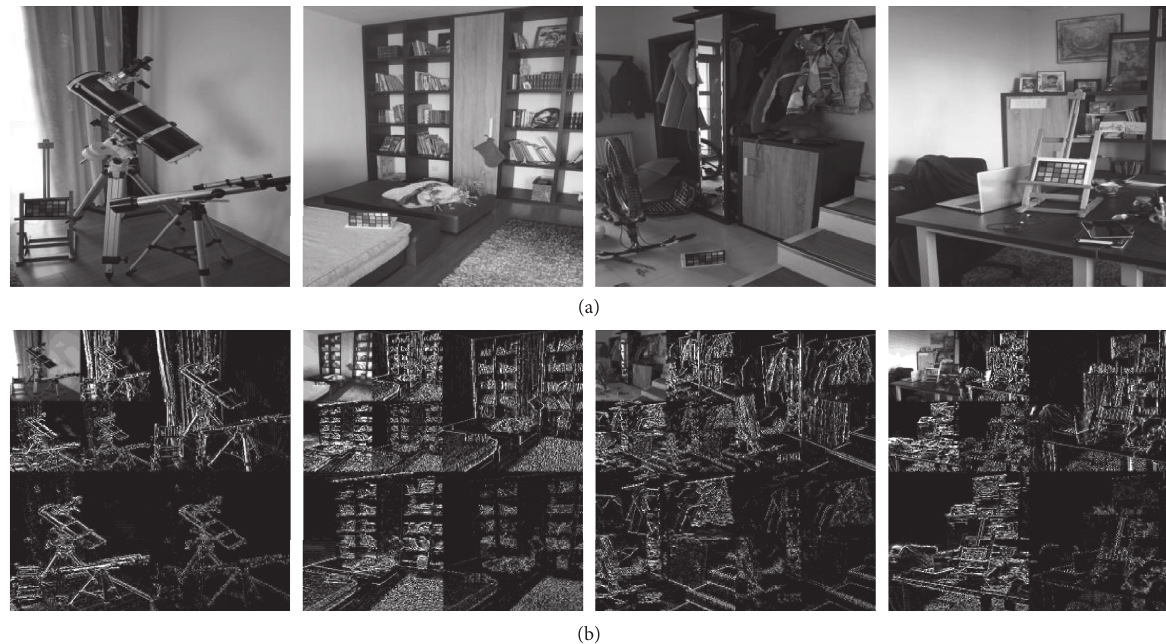
Figure 3: Two-level wavelet feature extraction diagram, (a) brightness components of different images, (b) wavelet transform feature extraction.